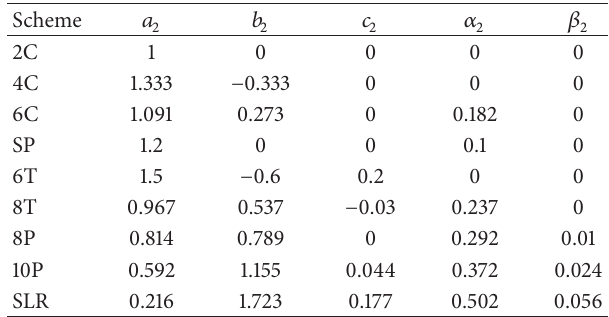
Table 1: Numerical parameters for the compact finite second (2C)-, fourth(4C)-,andsixth(6C)-ordercentraldifferences;standardPad´e (SP) schemes; sixth (6T)- and eight (8T)-order tridiagonal schemes; eighth (8P)- and tenth (10P)-order pentadiagonal schemes up to spectral-like resolution (SLR) schemes for chemical hardness of (18) [15, 24, 36, 63]. Scheme